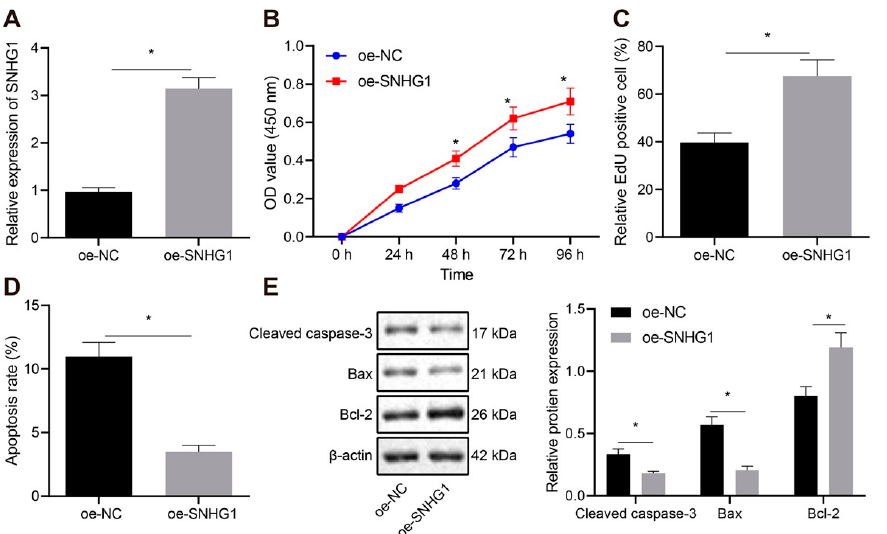
9 of 18 Figure 2. Silencing SNHG1 inhibits bladder cancer cell proliferation and promotes cell apoptosis. ( A ) qRT-PCR detecting the expression of SNHG1 in one normal urothelial cell line SV-HUC-1 and four bladder cancer cell lines (5637, T24, SW780, and UM-UC-3), and selection of T24 cells with the highest expression and 5367 cells with the lowest expression for subsequent experiments. T24 cells